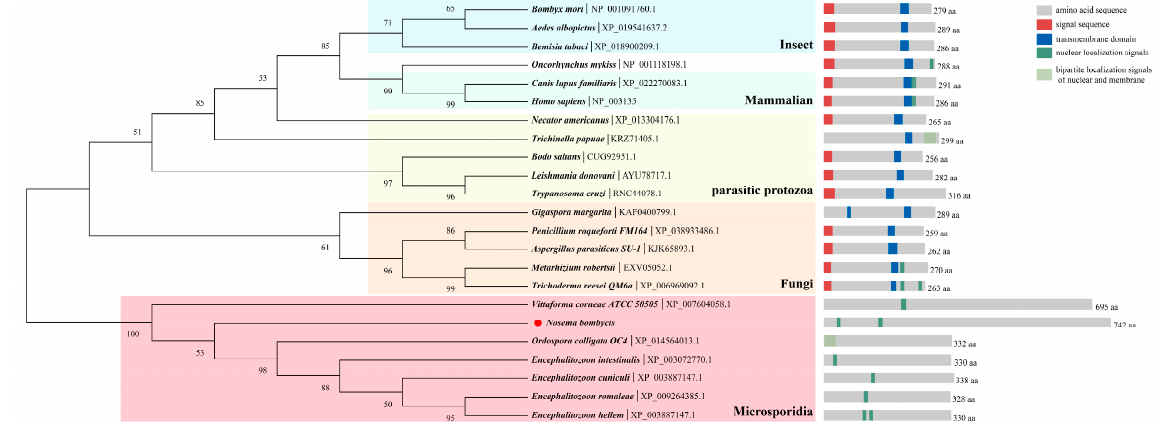
Figure 1. Phylogenetic analysis based on TRAP α in species and microsporidian HTRAP α using the maximum-likelihood method. Amino acid sequences downloaded from the NCBI database were used to construct a phylogenetic tree using MEGA 11 software. The Jones–Taylor–Thornton (JTT) model and bootstrap method with 1000 replications were selected to construct a maximum-likelihood tree. Signal peptide, transmembrane domain and nuclear localization signals were predicted by SignalP 5.0 (SignalP 5.0 Services, DTU Health Tech), DeepTMHMM (DTU/DeepTMHMM, BioLib), and cNLS Mapper (NLS Mapper (keio.ac.jp)), respectively. As the result shows, TRAP α from different species mainly clustered into four clades, and the HNbTRAP α clustered with other microsporidia homologues independently. The insects TRAP α are relatively close to mammalian ones. All mi- crosporidia TRAP α lacked signal sequence and transmembrane domains. The amino acid sequence lengths and function domain sites shown in the diagram are drawn to scale. Each species name is followed by the GeneBank ID or NCBI accession number of the